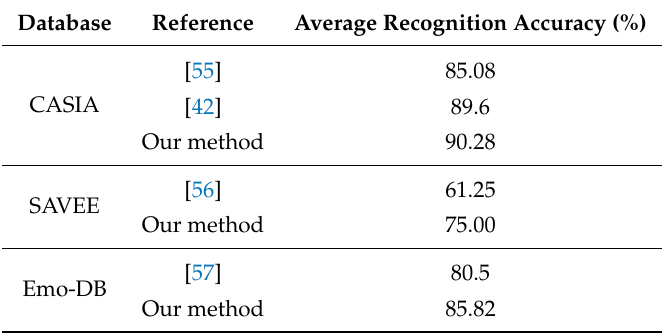
Table 13. Comparison between our method and some related